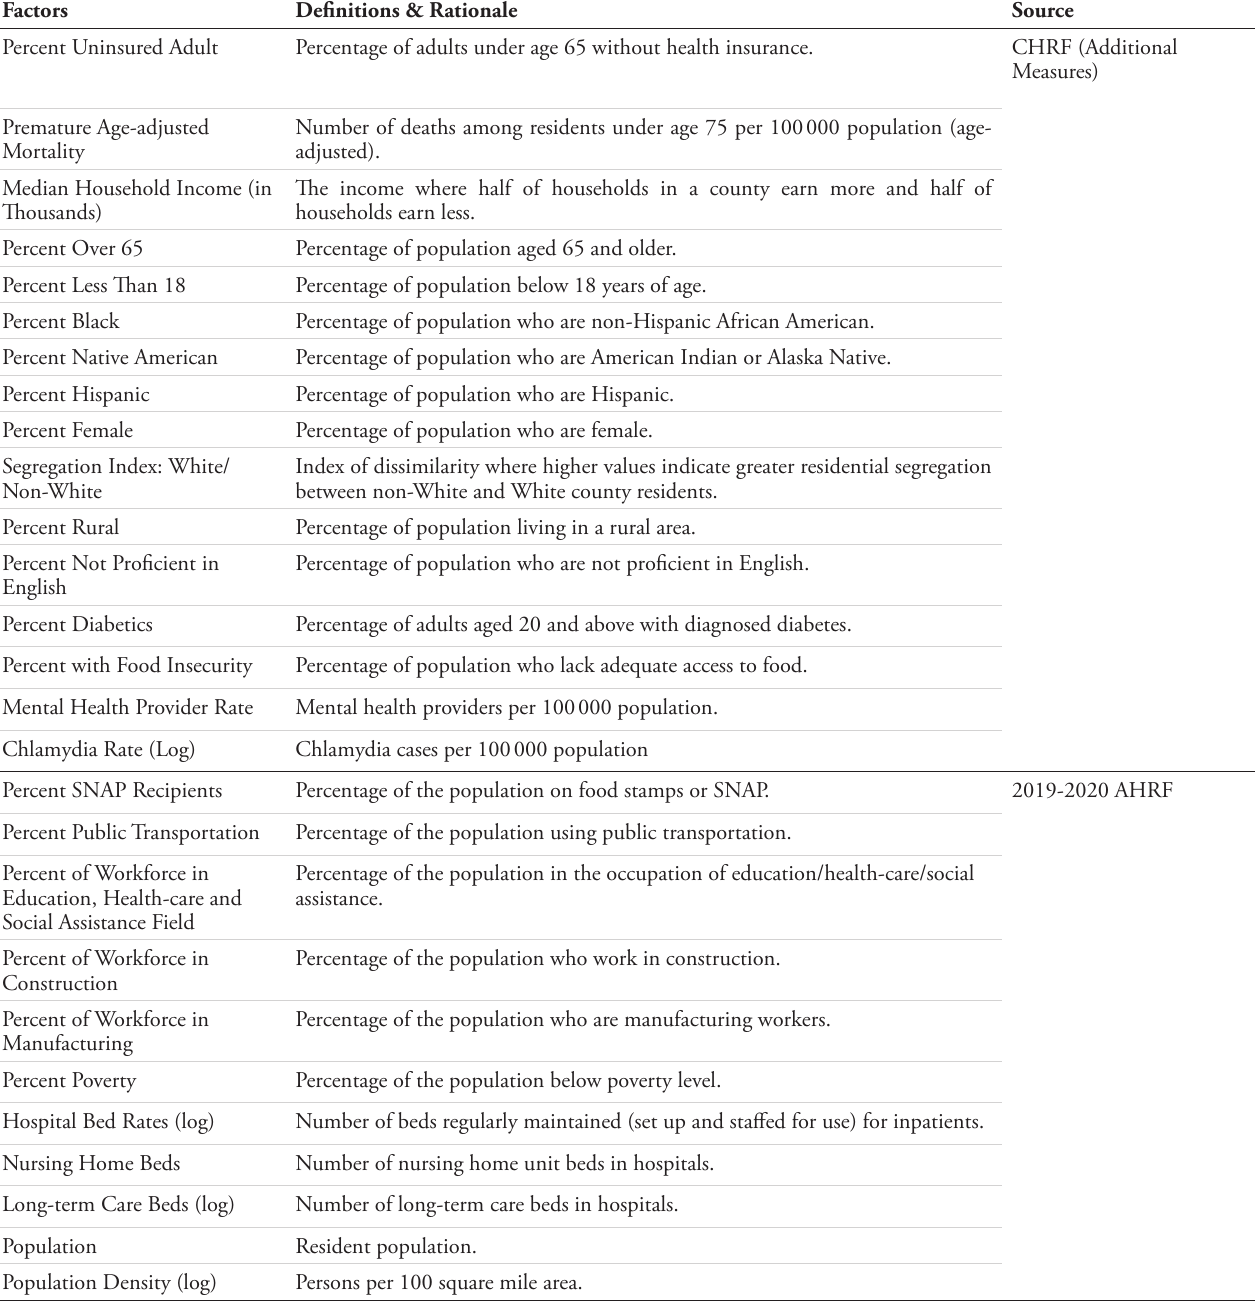
Table 1: Ecological Factors Used in the Analysis: Source Definitions and